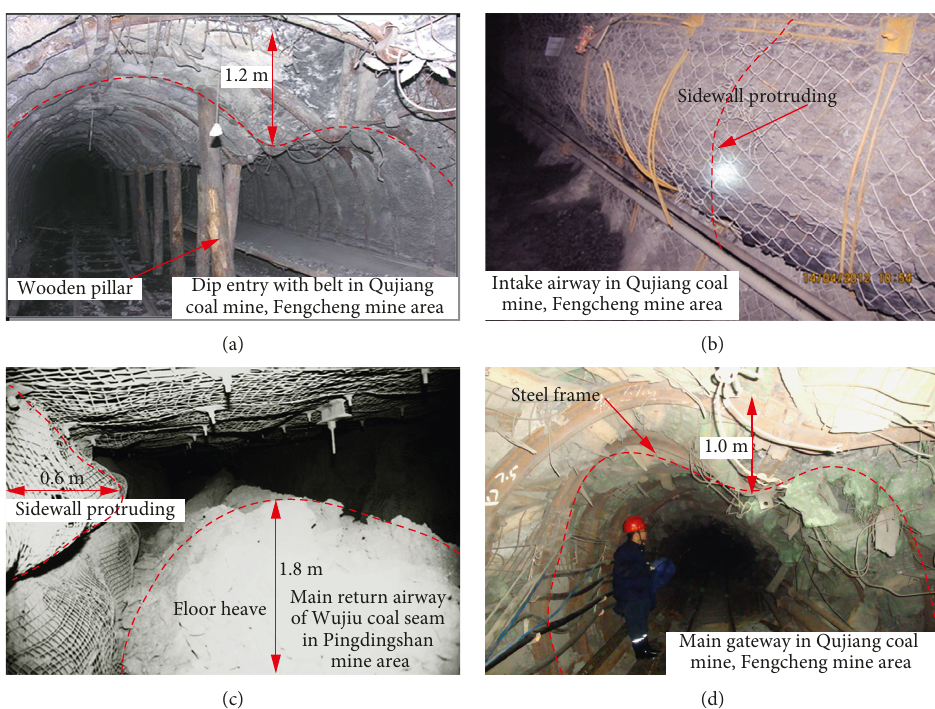
Figure 1: Main characteristics of deformation and failure for the deep roadway under mining-induced pressure.